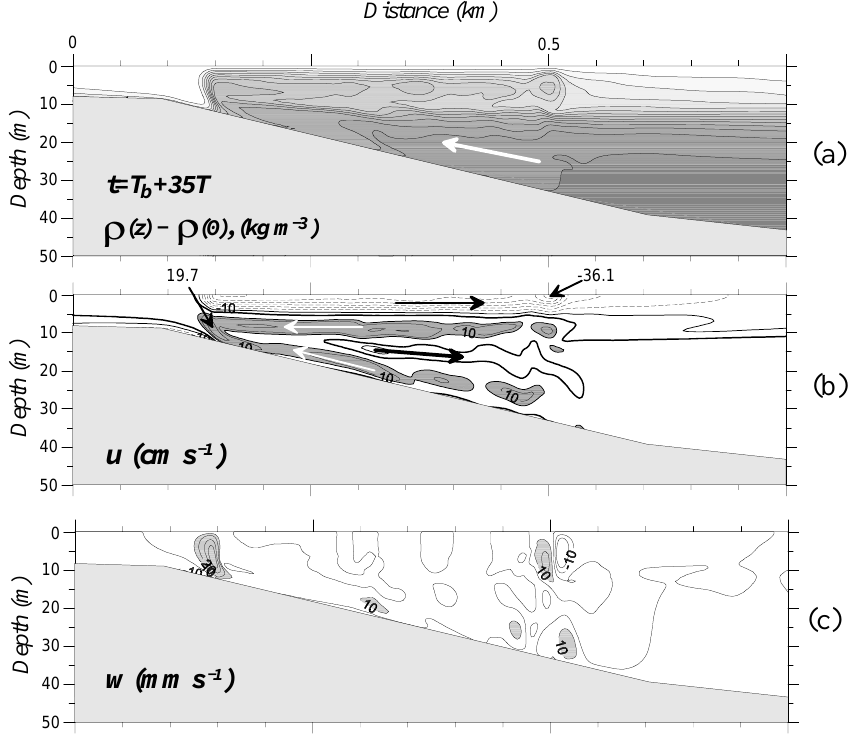
Fig. 11. The same as in Fig. 10 but 2905s after the wave breaking.